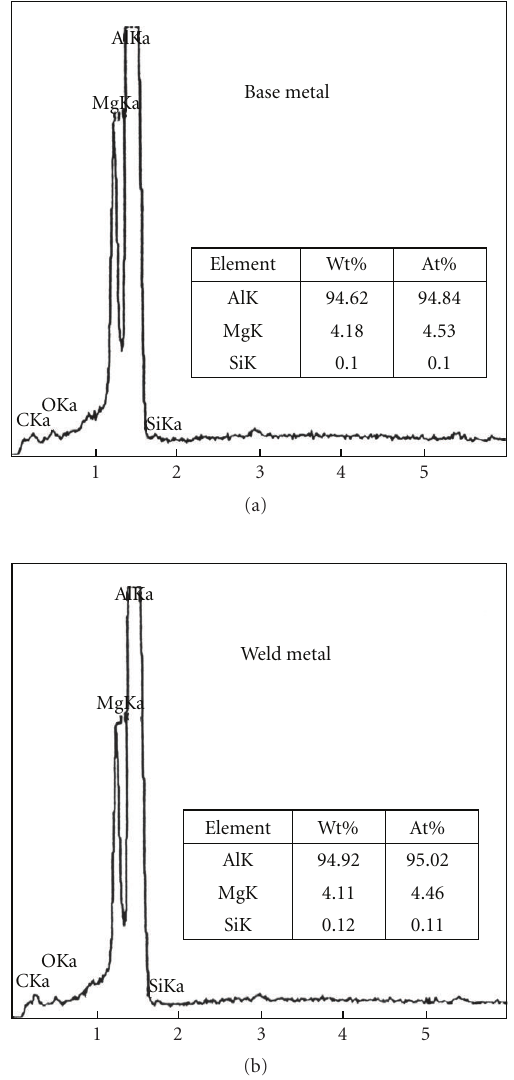
Figure 5: EDX microanalysis of base metal (a) and weld metal (b) of alloy AA5083 welded